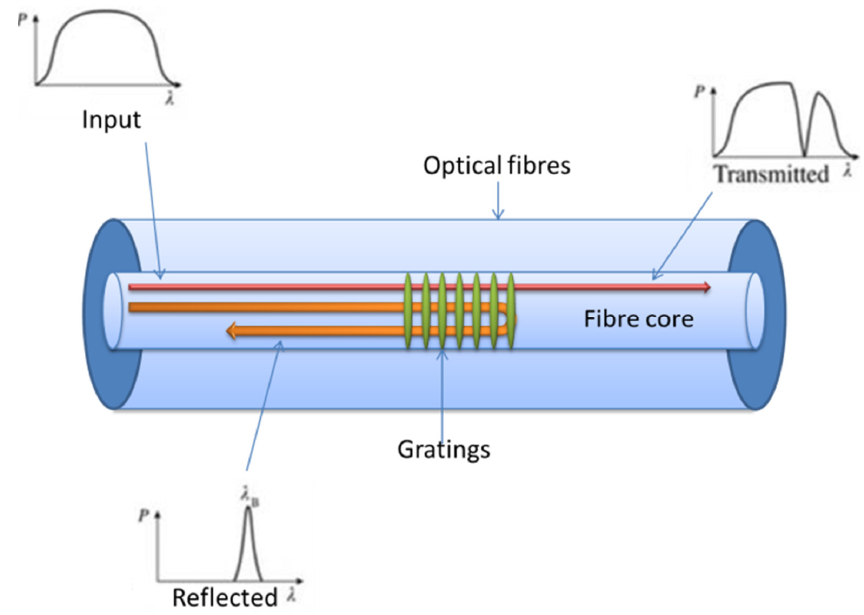
Figure 2. Schematic of a fibre Bragg grating (FBG) and its operating principle.